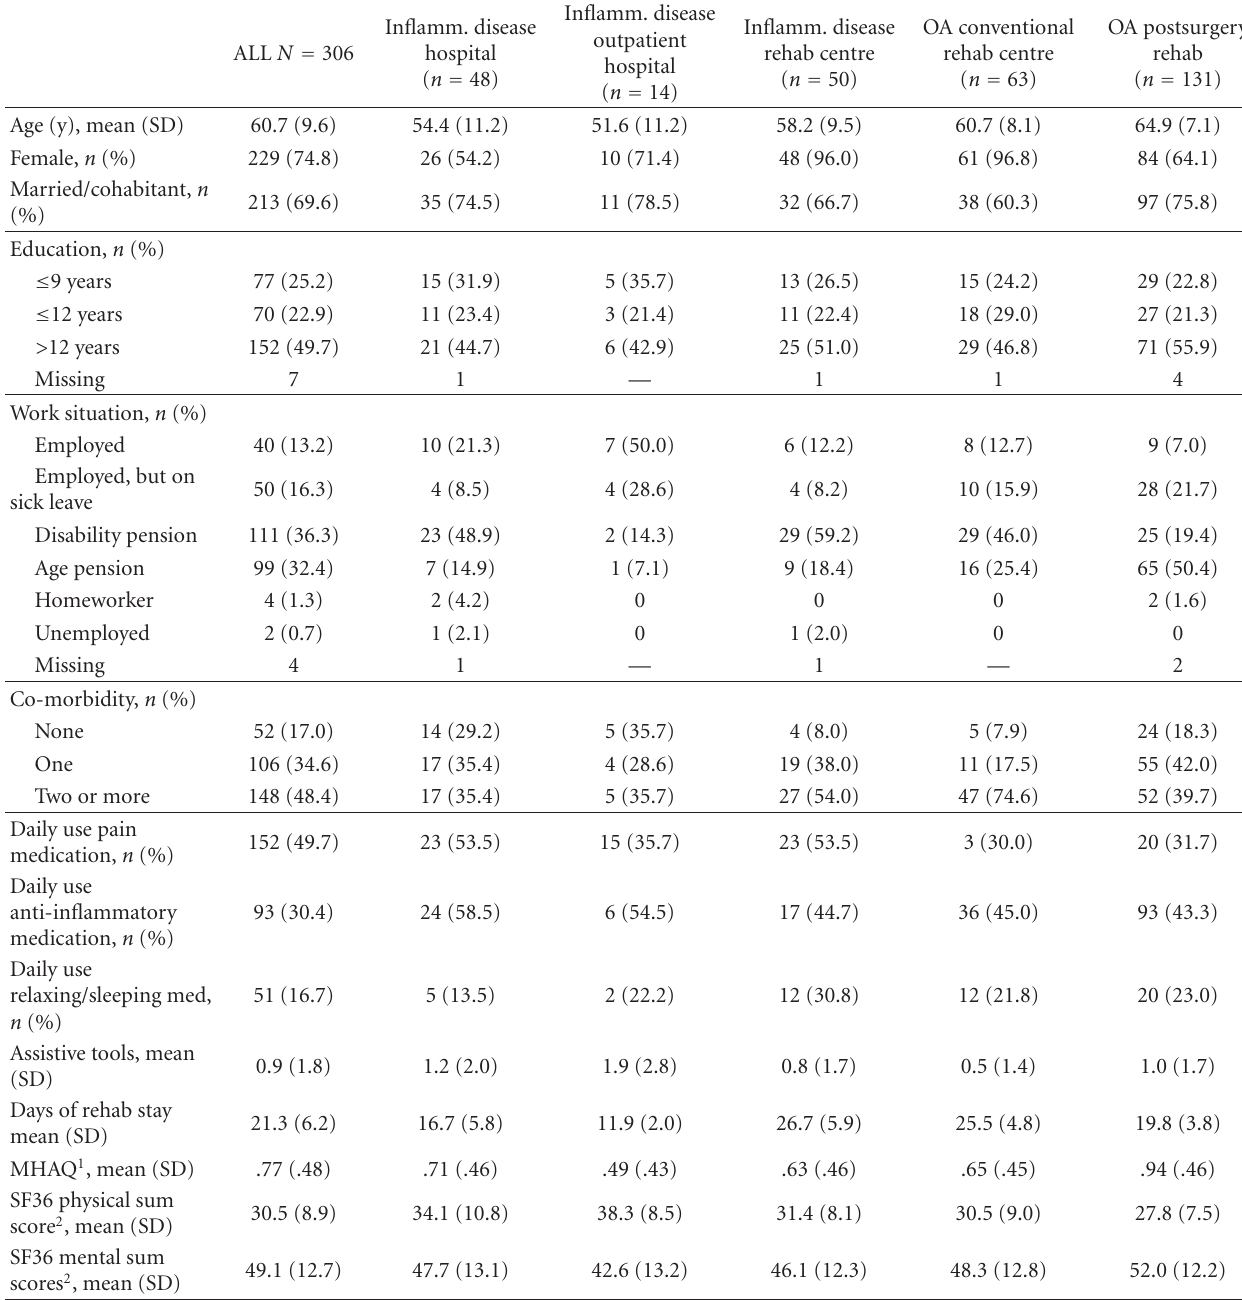
Table 2: Sociodemographic and health variables at baseline for the total sample ( n = 306) and for each of the diagnostic subgroups at hospital departments ( n = 62) and rehabilitation centres ( n =